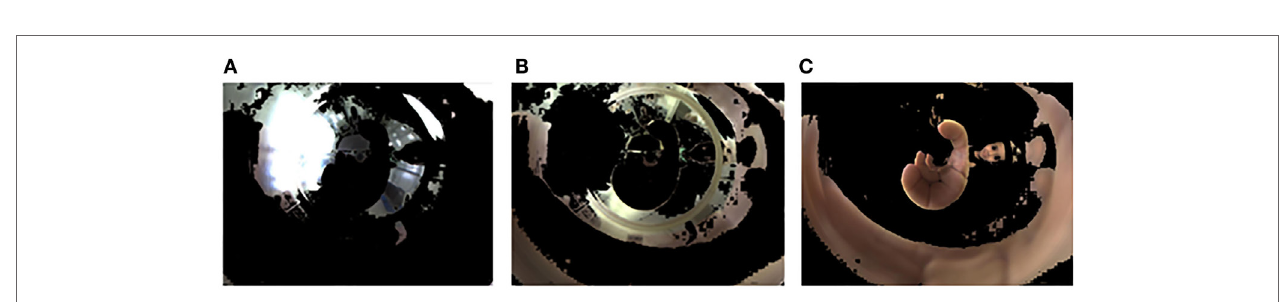
FIgURe 4 | (A) Objects in cluster 1; (B) Objects in cluster 2; (c) Objects in cluster 3.